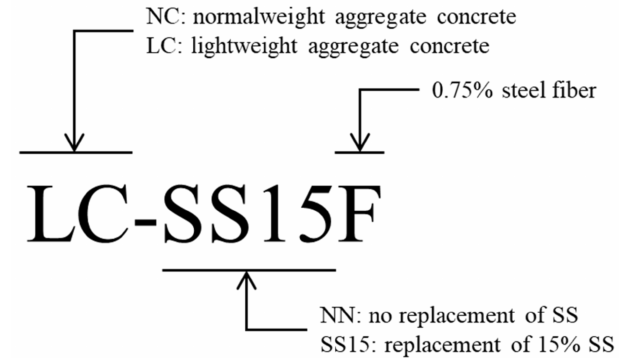
Figure 1. Designation of test